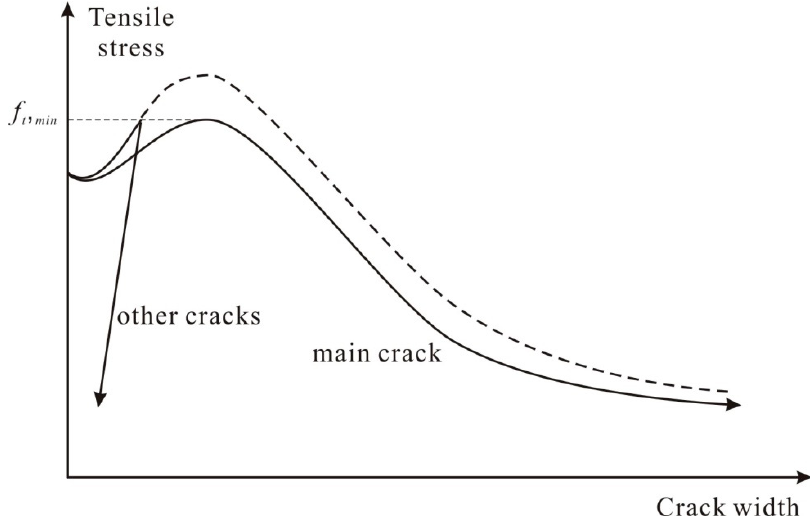
Figure 4. Tensile stress-crack width opening response at the main crack and the others.